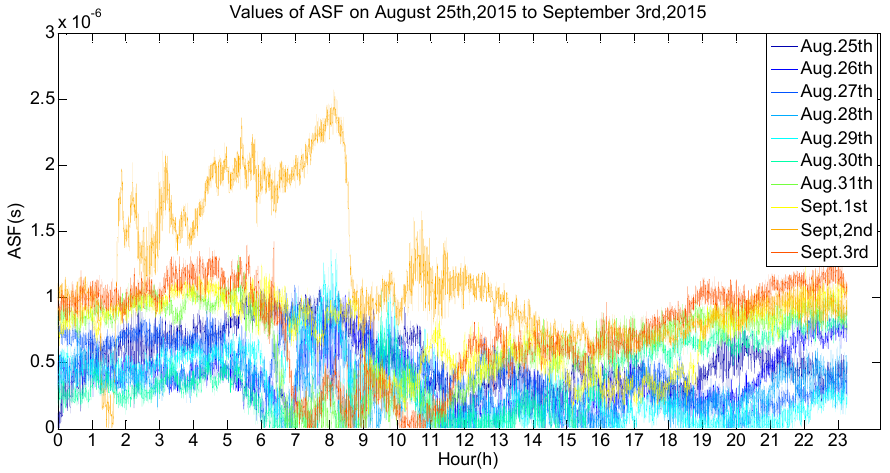
Figure 11. The ASF data from 25 August–3 September 2015.